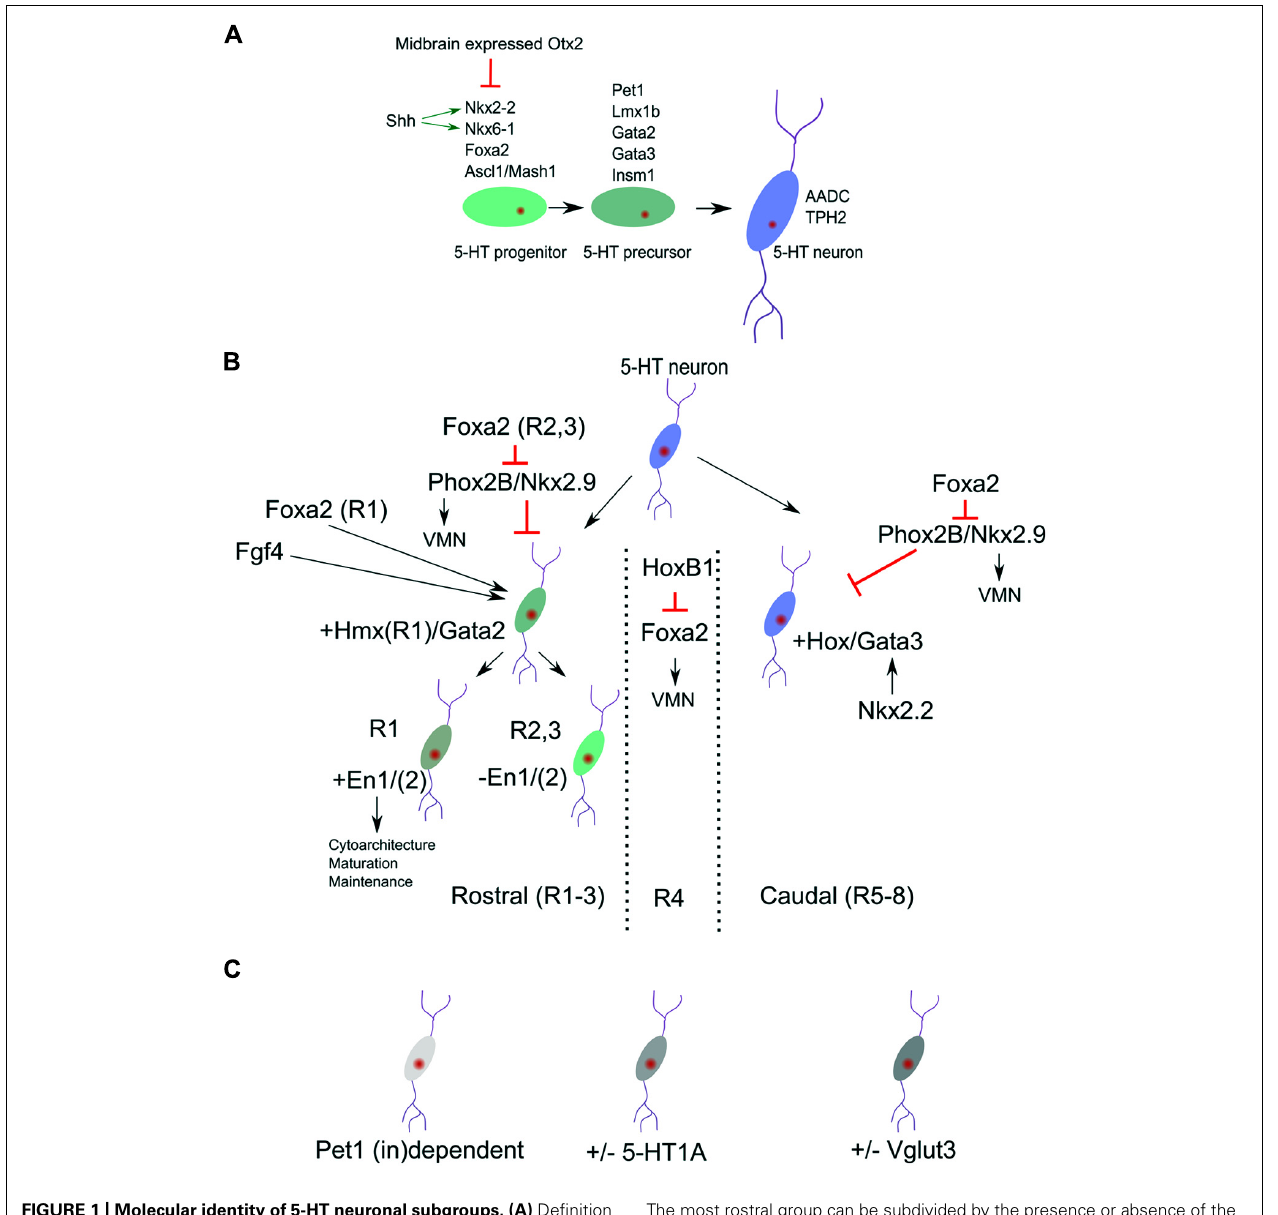
FIGURE 1 | Molecular identity of 5-HT neuronal subgroups. (A) Definition of broads programs of 5-HT neuronal specification. (B) The general pool of 5-HT neurons is molecularly divided in a rostral and caudal subgroup.These subgroups are identified by the presence of Hmx/Gata2 and Hox/Gata3 genes.